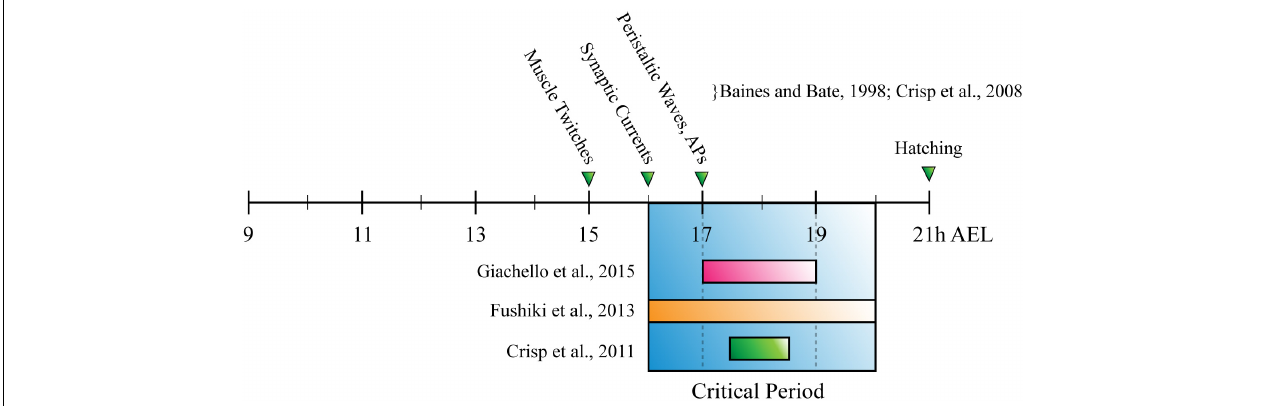
FIGURE 3 | The Drosophila Larva Critical Period for Locomotor Development. Timeline for Drosophila embryonic development, measured in hours after egg laying (h AEL). Research has described the critical period for locomotor development (blue box) as being: (1) 17–19h, through manipulation of cholinergic neuron activity (pink bar); (2) 2 h between 16–20 h AEL, through manipulation of chordotonal neuron input to the nervous system (orange bar); (3) 90–30 min before tracheal filling, or ∼ 17 h 30 min–18 h 30 min AEL (green bar). These timings overlap with each other, occurring shortly after the appearance of myogenic movements (muscle twitches) and around the same time as the emergence of synaptic currents and peristaltic